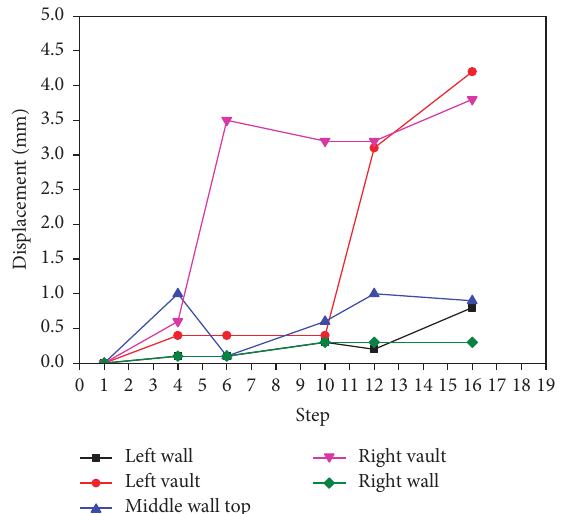
Left wall: during the construction of the side pilot tunnel, the stress of the surrounding rock at this place is the most unfavorable, and the damage proximity reaches 0.82. However, the construction of the main tunnel of the left tunnel is beneficial to stabilize the surrounding rock at this place, and the damage proximity is reduced to 0.73.